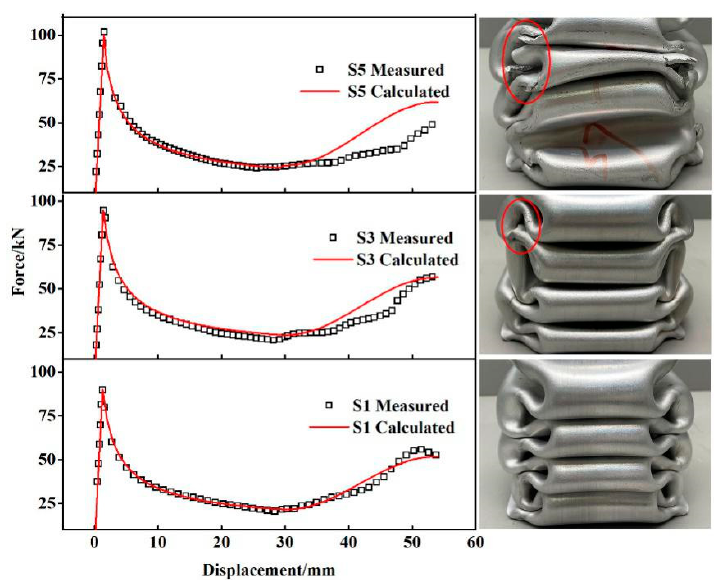
Figure 14. Comparison of calculated and measured results of the first three stages.